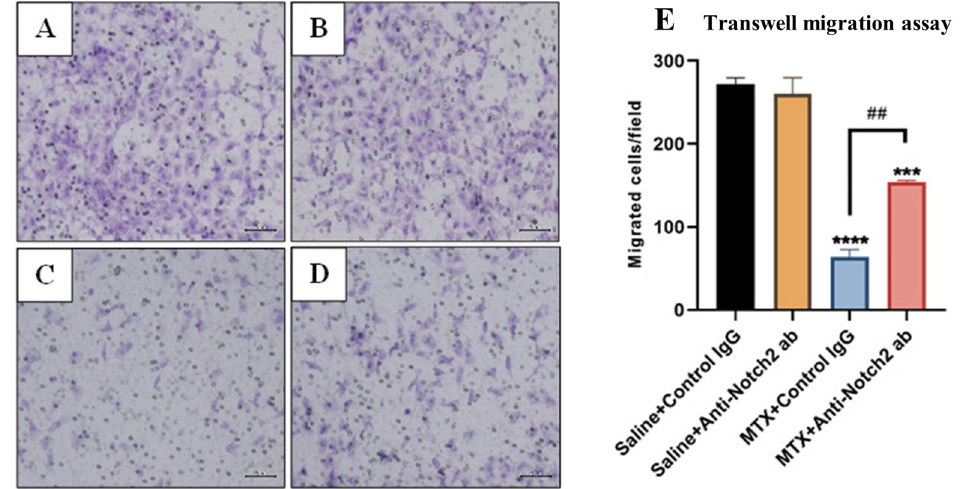
Figure 6. Treatment effects of MTX with/without anti-Notch2 antibody (ab) on migration ability of rat bone marrow-derived endothelial cells (BMECs) as assessed by a transwell migration assay. Represen- tative microscopic images illustrate migrated cells stained with Crystal Violet in ( A ) Saline+Control IgG group, ( B ) Saline+Anti-Notch2 antibody group, ( C ) MTX+Control IgG group and ( D ) MTX+Anti- Notch2 antibody group. Scale bar is 200 µ m. ( E ) Average numbers of migrated cells per field (as mean ± SEM) from three independent experiments. *** p < 0.001 and **** p < 0.0001 compared to control IgG, and ## p < 0.01 compared between MTX treatment